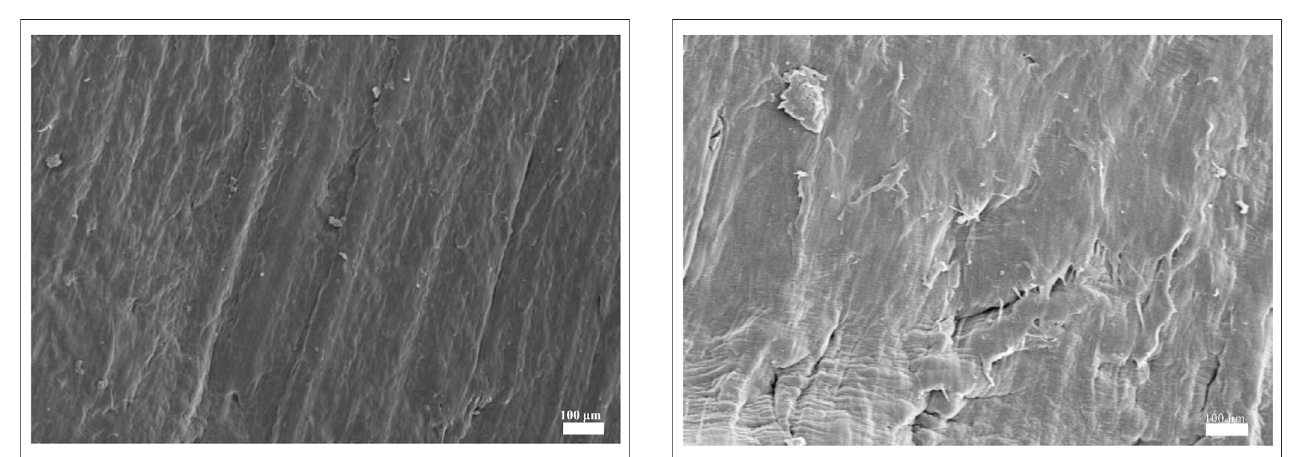
FIGURE 7 | Microstructure morphology of the HDPE geonet during the tensile